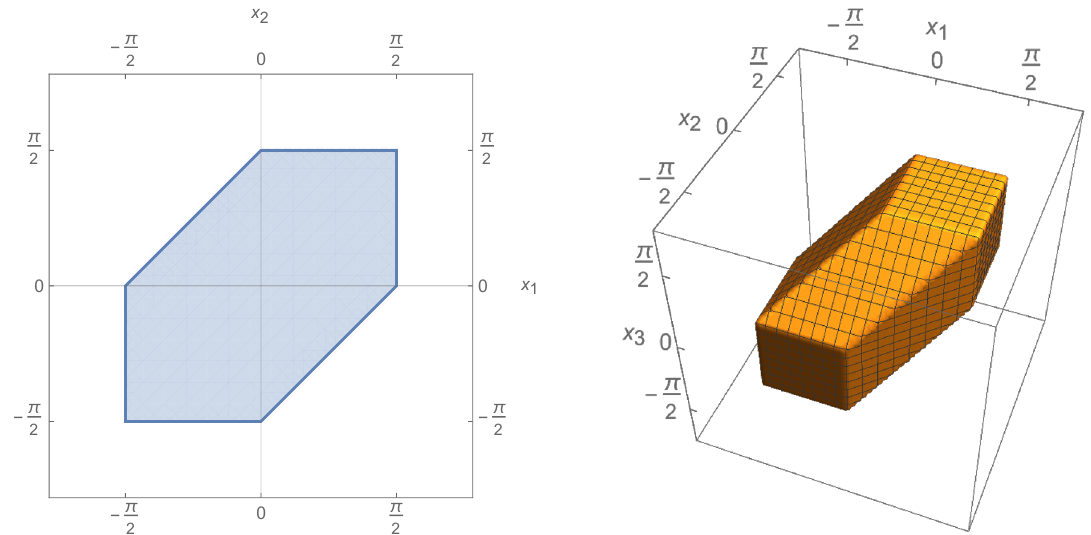
Figure 6 . Con(cid:12)guration space A 0 \ [ (cid:0) (cid:25)= 2 ; (cid:25)= 2] N of the auxiliary operator H 0 for N = 2 (left) and N = 3 (right). In general, the con(cid:12)guration space is an irregular N -polytope with N ( N + 1)